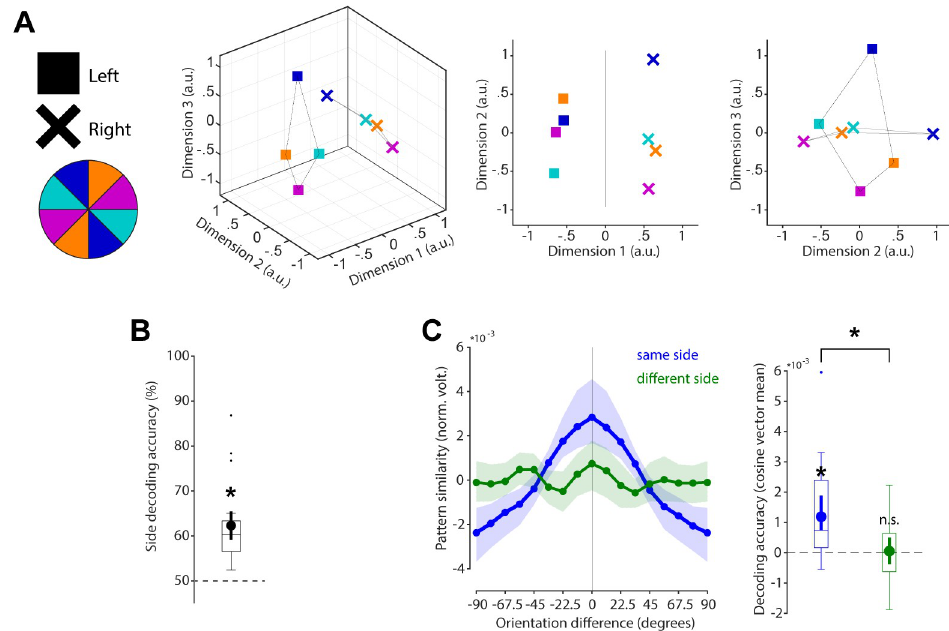
Fig 5. No cross-generalisation of coding scheme between cued item locations during impulse responses. (A) Visualisation of orientation and item location code in state space. The first dimension discriminates between item locations. The first and second dimensions code the orientation space, separately for WM items previously presented on the left or right side. (B) Trial-wise accuracy (%) of item location decoding. (C) Orientation decoding within each item location (blue) and orientation code cross-generalising between different item locations (green). Error shadings and error bars are 95% CI of the mean. Asterisks indicate significant decoding accuracies and differences ( p < 0.05). Data available at osf.io/cn8zf. a.u., arbitrary units; norm. volt., normalised voltage; n.s., not significant; WM, working memory.